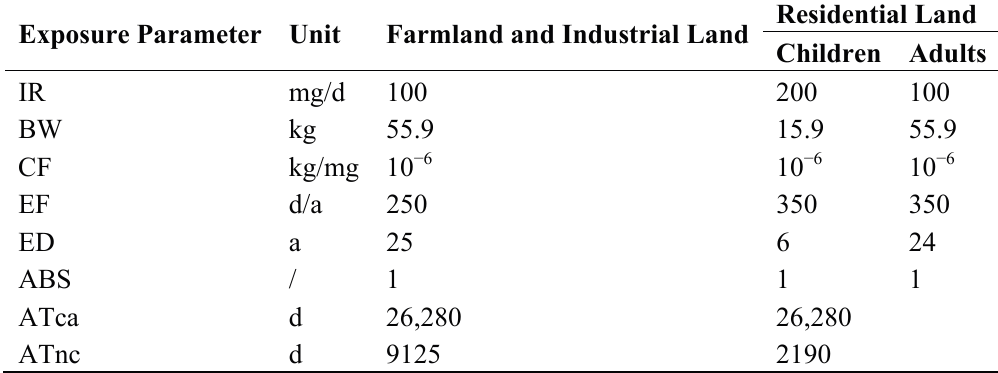
Table A3. Exposure assessment parameters (From the Technical Guidelines for Risk Assessment of Contaminated Sites HJ 25.3-2014